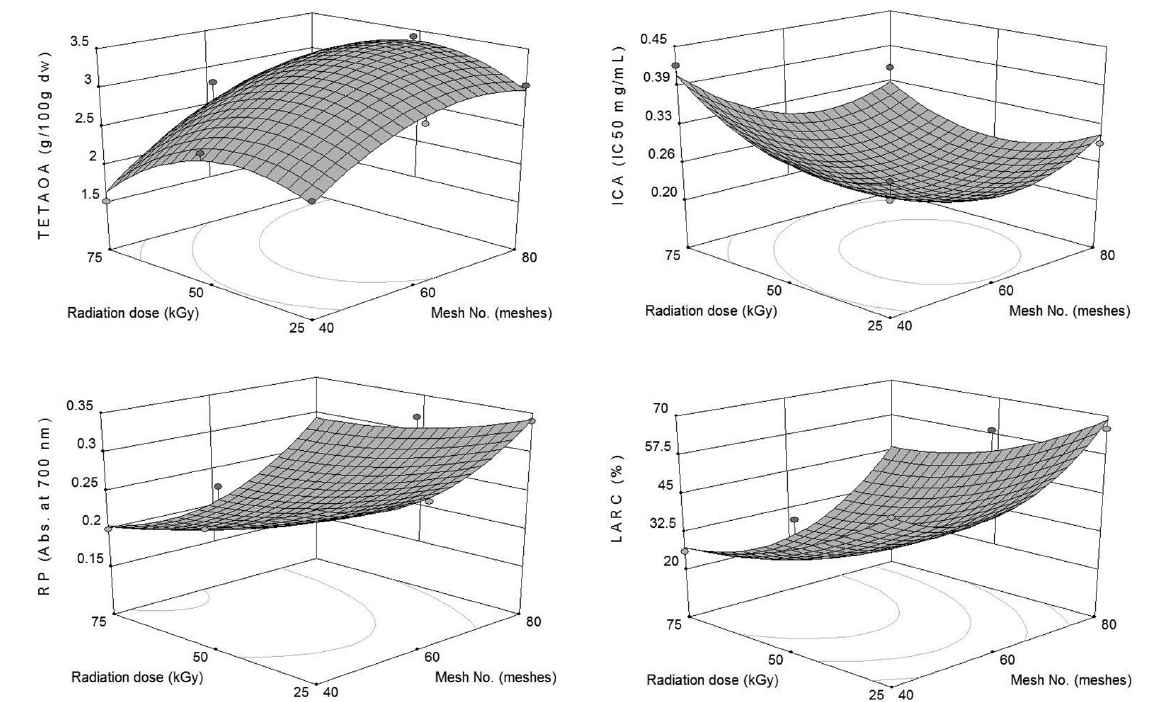
FIGURE 1 - 3D response surface plots of antioxidant properties of maize flour at various levels of particle size and radiation dose.